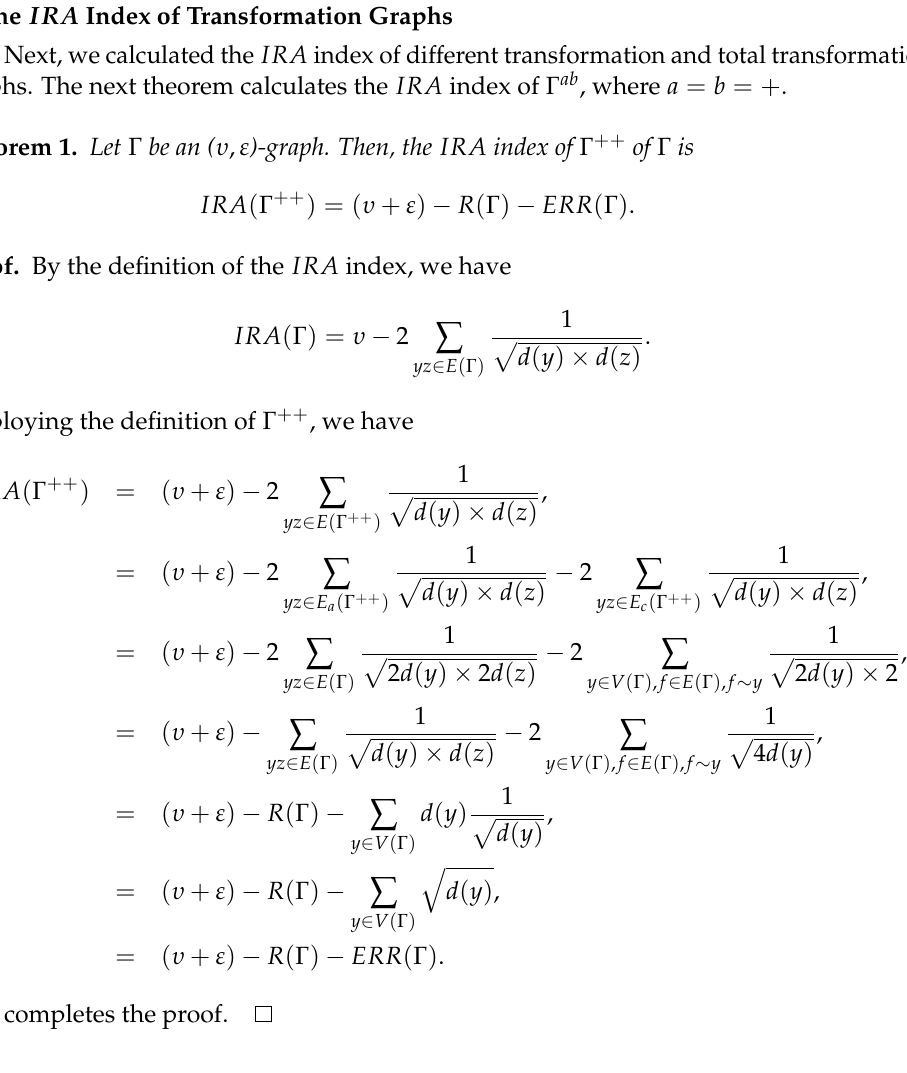
Between IRA and ∆ T bp Between IRA and ∆ H o